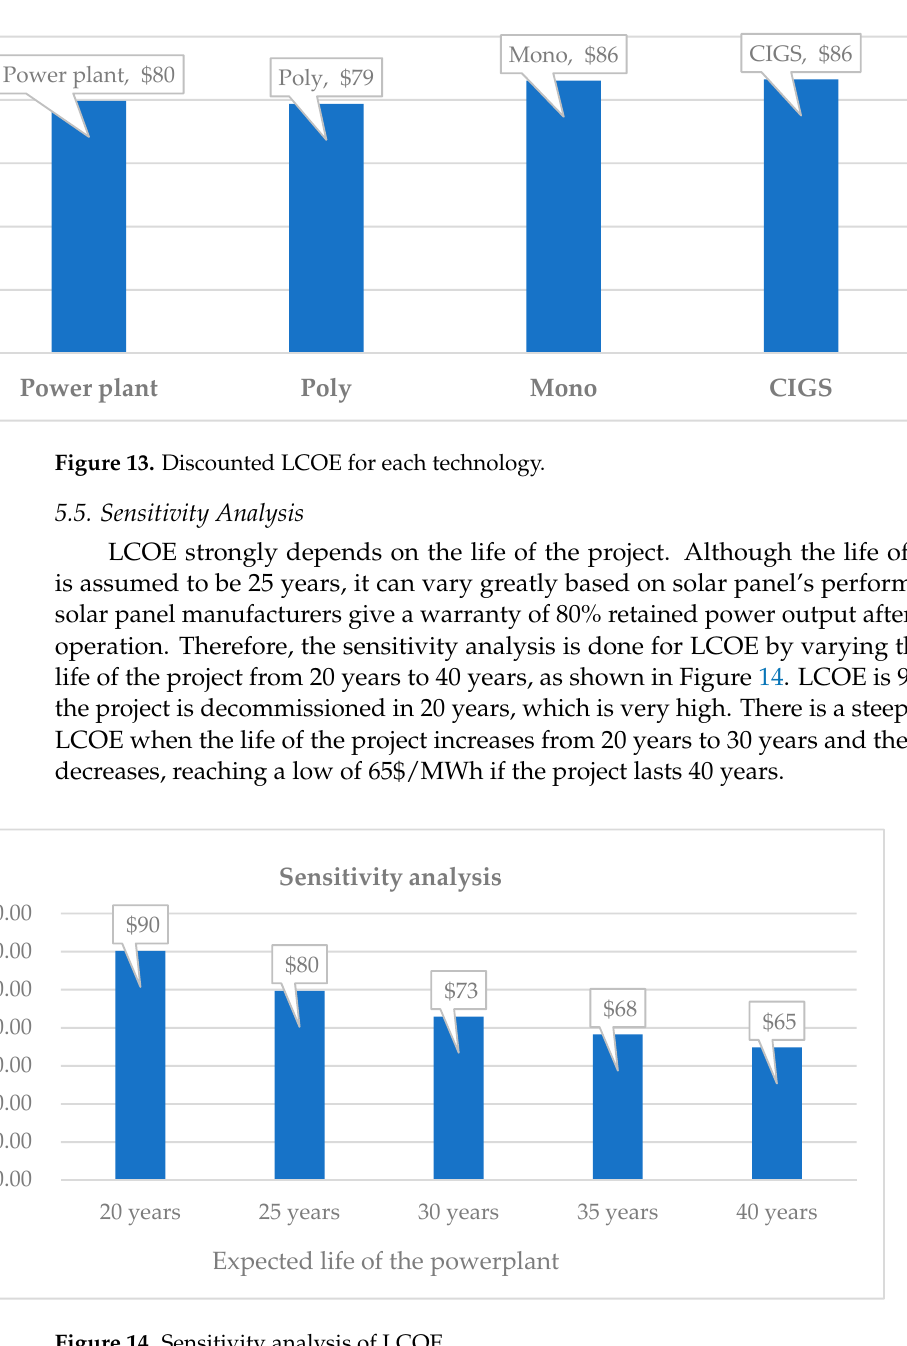
Figure 15. Comparison of actual energy generated and performance ratio to simulated values for polycrystalline silicon array.